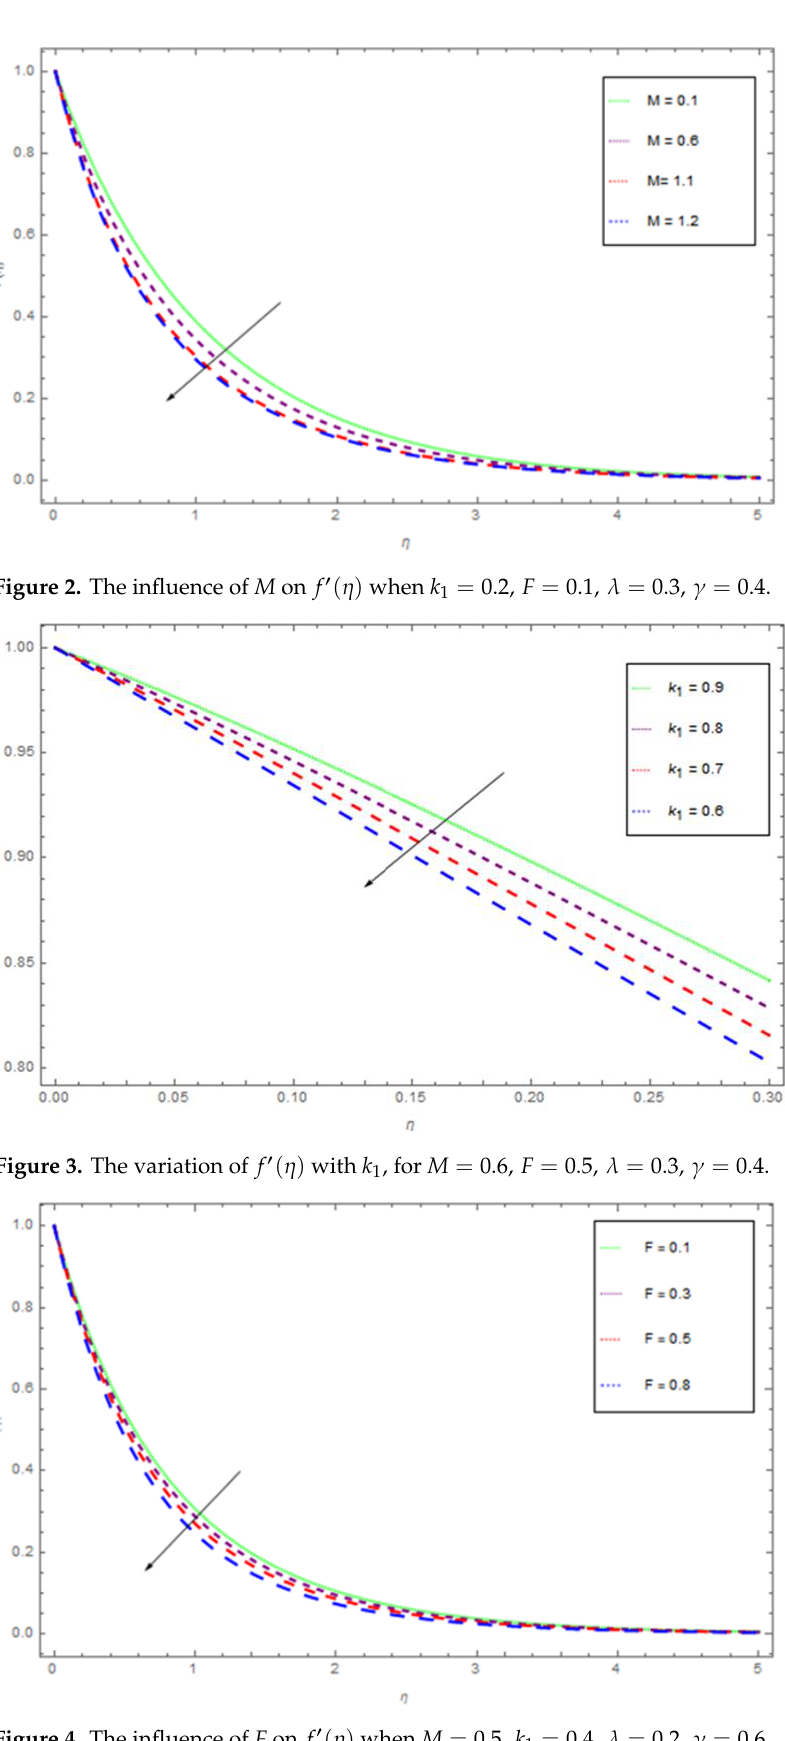
Figure 4. The influence of F on f (cid:48) ( η ) when M = 0.5, k 1 = 0.4, λ = 0.2, γ =